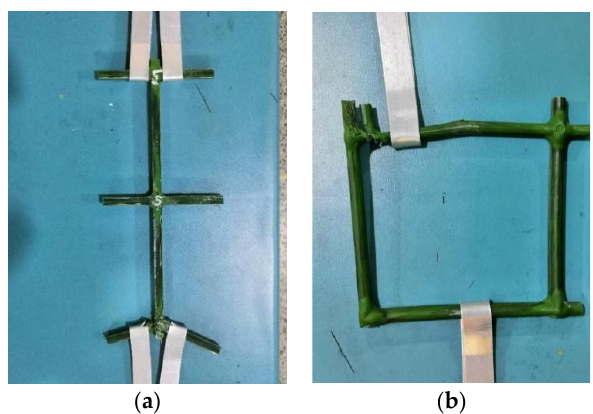
Figure 2. Failure of specimen. ( a ) Single BFR. ( b ) BFR mesh.